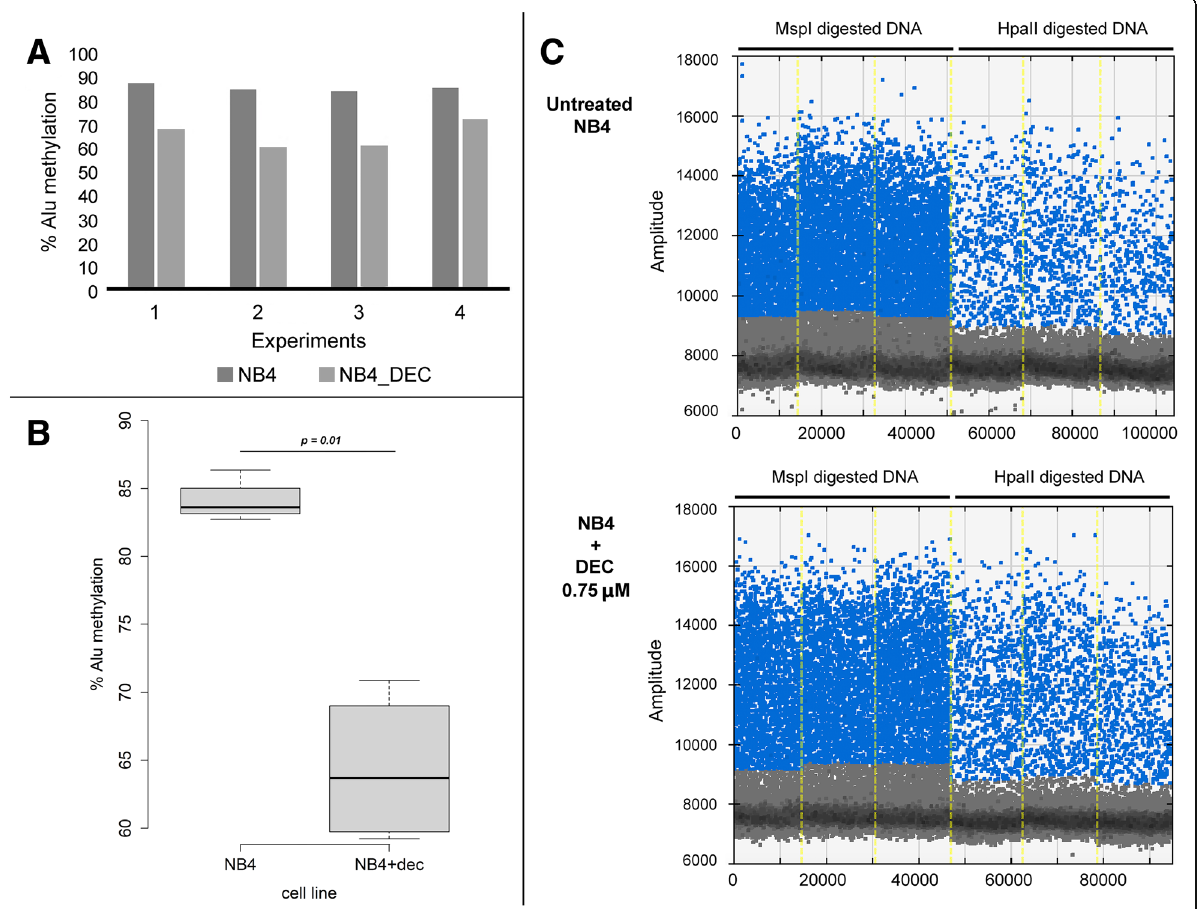
Fig. 3 Methylation analysis with ddPCR assay in NB4 cell line. a Methylation level analysis of the NB4 cell line in the four experiments. b Box plot representation of DNA methylation levels in the untreated NB4 cell line or post treatment with hypomethylating agent. c ddPCR assay for the NB4 cell line in two different conditions: untreated or treated with DEC 0.75 uM. The percentage of methylated consensus Alu sequences is calculated as the ratio between the sum of the three values of positive droplets compared to HpaII (MH) and MspI (MM) diluted digestion-ligation mixtures. DEC,